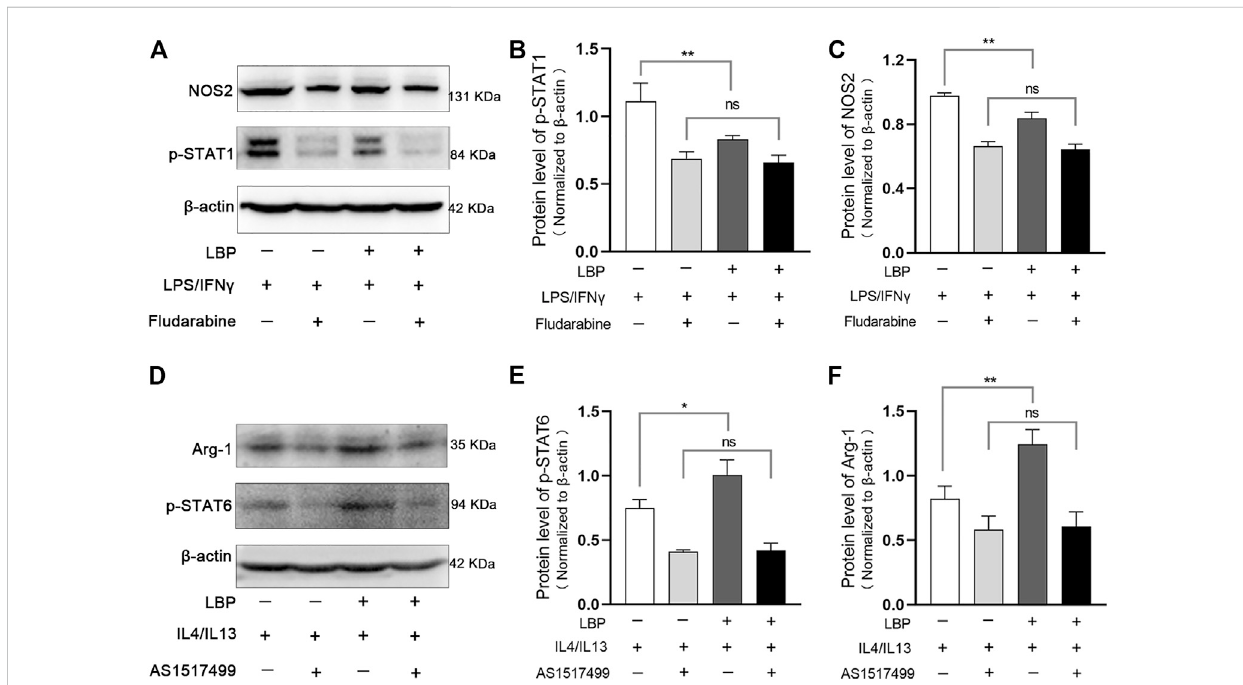
FIGURE 7 LBP regulates M1/M2 macrophage polarization through the STAT1 and STAT6 pathways. (A) RAW264.7 cells were stimulated with LPS/IFN- γ , then treated with LBP or Fludarabine alone or together. The treated cells were collected for Western blot. Representative Western blot images of p-STAT1, NOS2, and ß -actin. (B) The quanti fi cation of the Western blot bands of p-STAT1 in Figure 7A. (C) The quanti fi cation of the Western blot bands of NOS2 in Figure 7A. (D) RAW264.7 cells werestimulatedwith IL4/IL13,then treated with LBPorAS1517499 alone ortogether. Thetreated cells werecollected for Western blot. Representative Western blot images of p-STAT6, Arg-1, and ß -actin. (E) The quanti fi cation of the Western blot bands of p-STAT6 in Figure 7D. (F) The quanti fi cation of the Western blot bands of Arg-1 in Figure 7D. Signi fi cant differences are indicated as * p < 0.05, ** p < 0.01. Ns, no signi fi